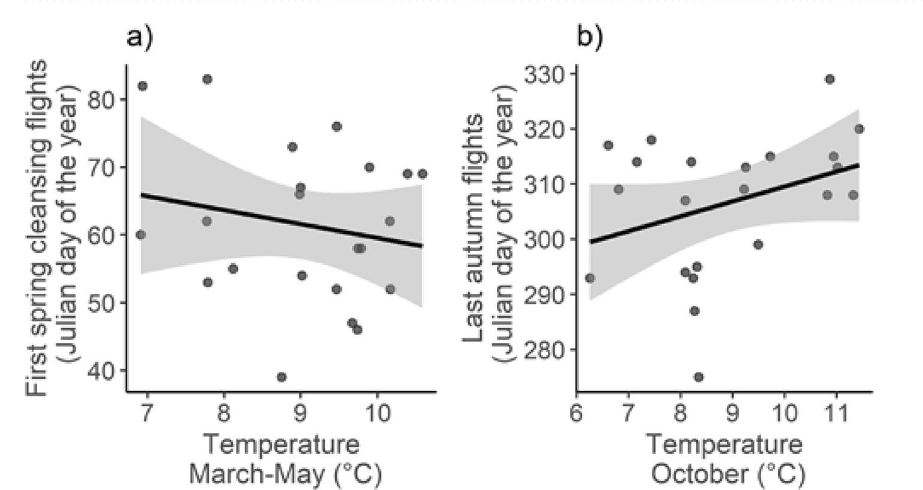
Figure 5. Phenology of the first spring cleansing flights ( a ) and last autumn flights ( b ) of the bees in relation to the temperature conditions during the first ( a ) and the second ( b ) critical time